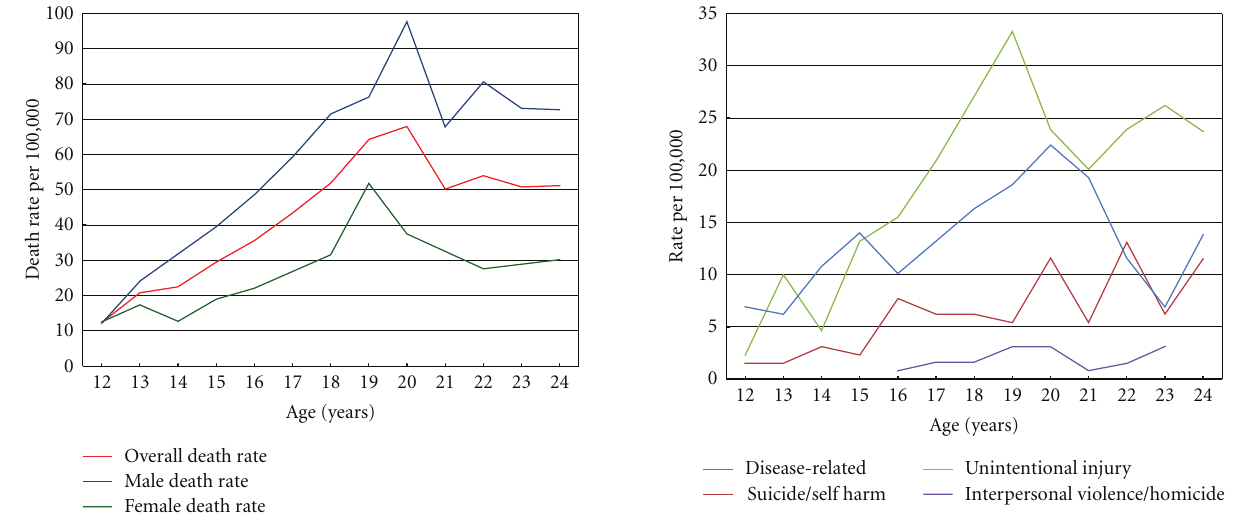
Figure 2: Death rates by age per 100,000 youth, overall and by male and female.